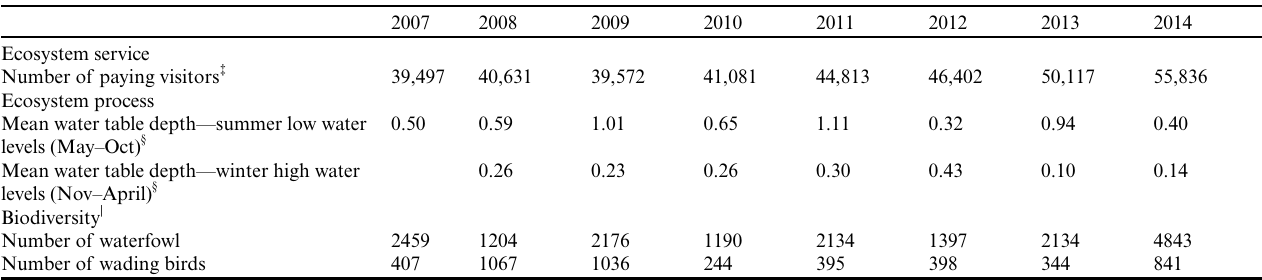
Table 3 . Selected annual monitoring data from the Wicken Fen Vision project. Bivariate correlation analyses between pairs of variables, using Pearson correlation tests, show only one weakly significant correlation between visitor numbers and waterfowl numbers ( r 6 = 0.709, R 2 = 0.503, p = 0.049). Numbers of all species of wetland birds are counted monthly by volunteers on part of the Wicken Fen Vision Project, using the British Trust for Ornithology Wetland Bird Surveys (WeBS) protocol. † The WeBS year runs from July to June. Depth of water table below ground level values are collected from data loggers at the main site where the WeBS counts are made. Visitor numbers are those that pay to visit the National Nature Reserve (NNR) area of Wicken Fen. The whole of the Wicken Fen Vision area is free to visit. Visitor surveys by Peh et al. (2014) showed that 28% of all visitors visited only the NNR, 42% visited only the restoration project area, and 30% visited both the NNR and the project area (the visitor year runs from March to February).